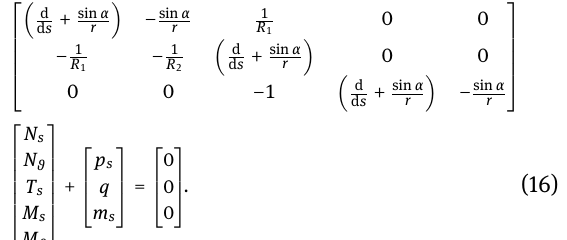
Figure 9: Equilibrium of a shell of revolution: (a) translation along the meridian; (b,c) rotation about the parallel; (d,e) translation along the normal to the